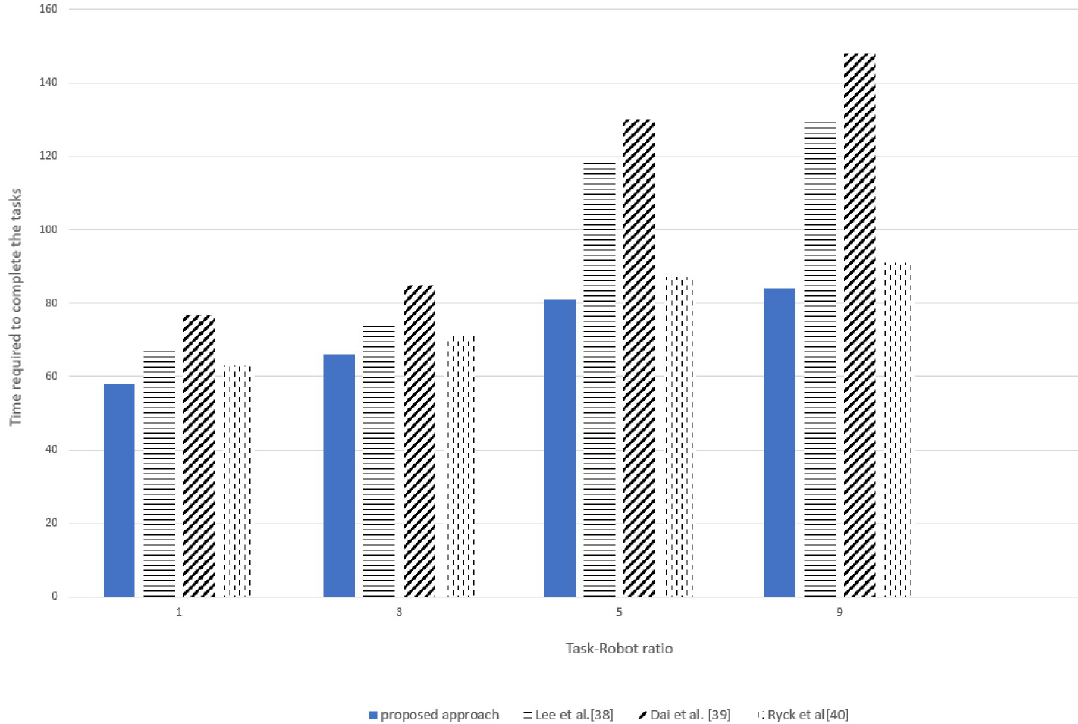
Fig 12. Time required for various task-robot ratio with real